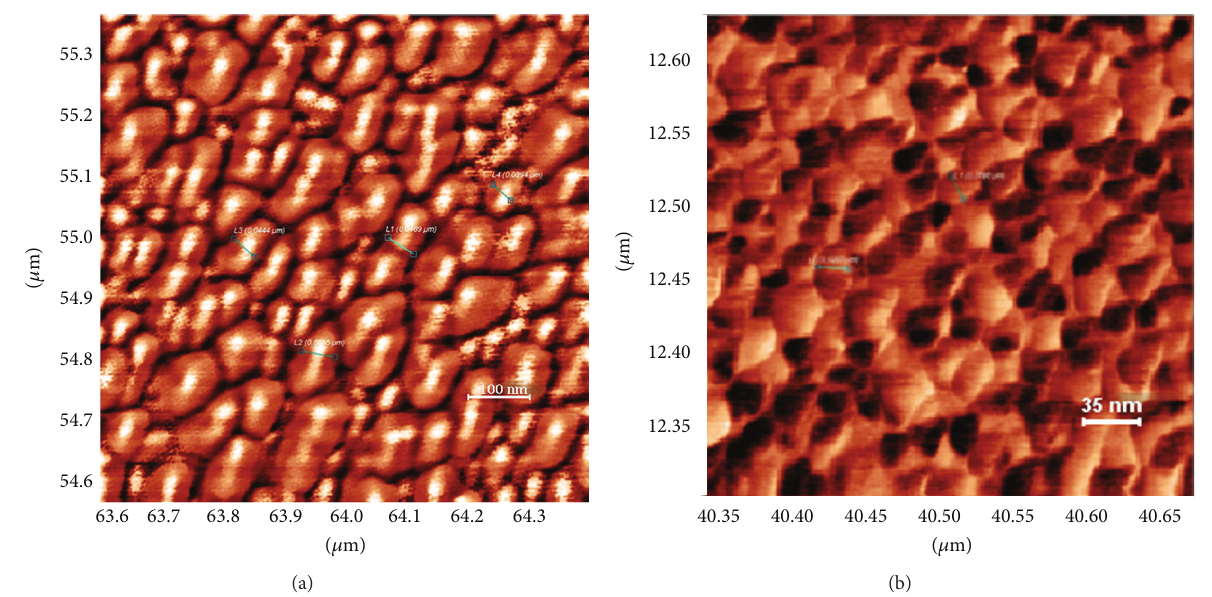
Figure 4: AFM micrographs of thin film surface for (a) Zn 0.97 Fe 0.03 O and (b) Zn 0.90 Fe 0.10